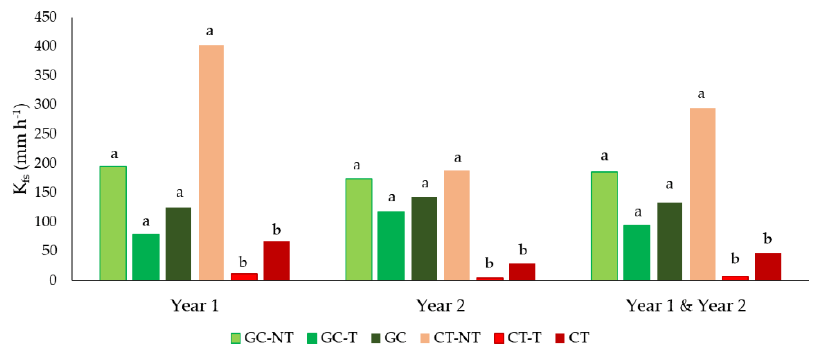
Figure 6. Mean values of the field-saturated hydraulic conductivity (K fs ) measured in the plots. Letters indicate significant difference between series, obtained with t-test ( p = 0.05).